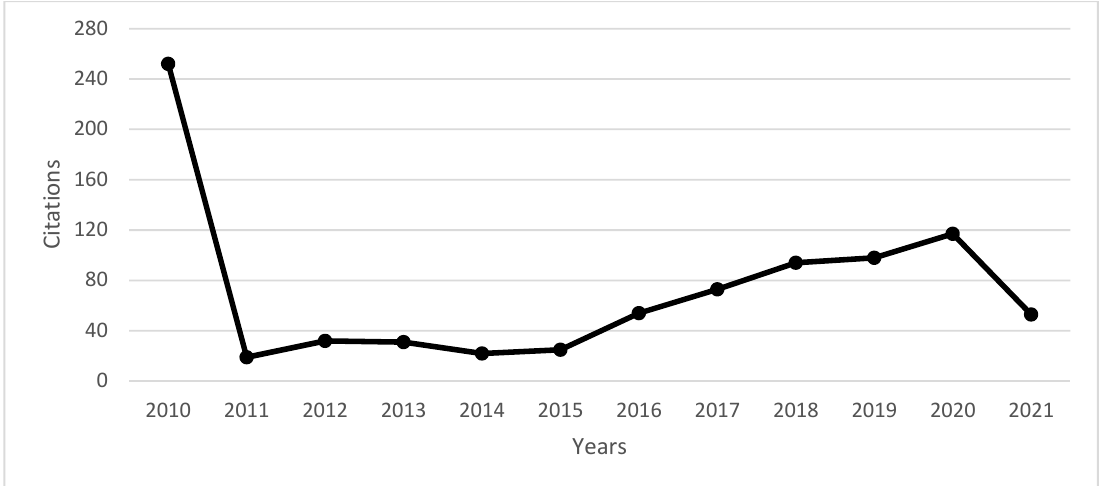
Figure 3. Evolution and number of citations between 2010 and 2021. Source: own elaboration.